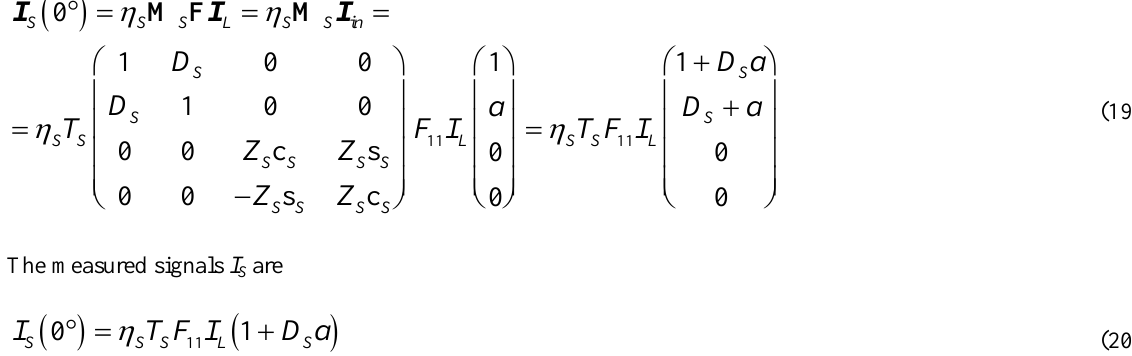
The measured signals I